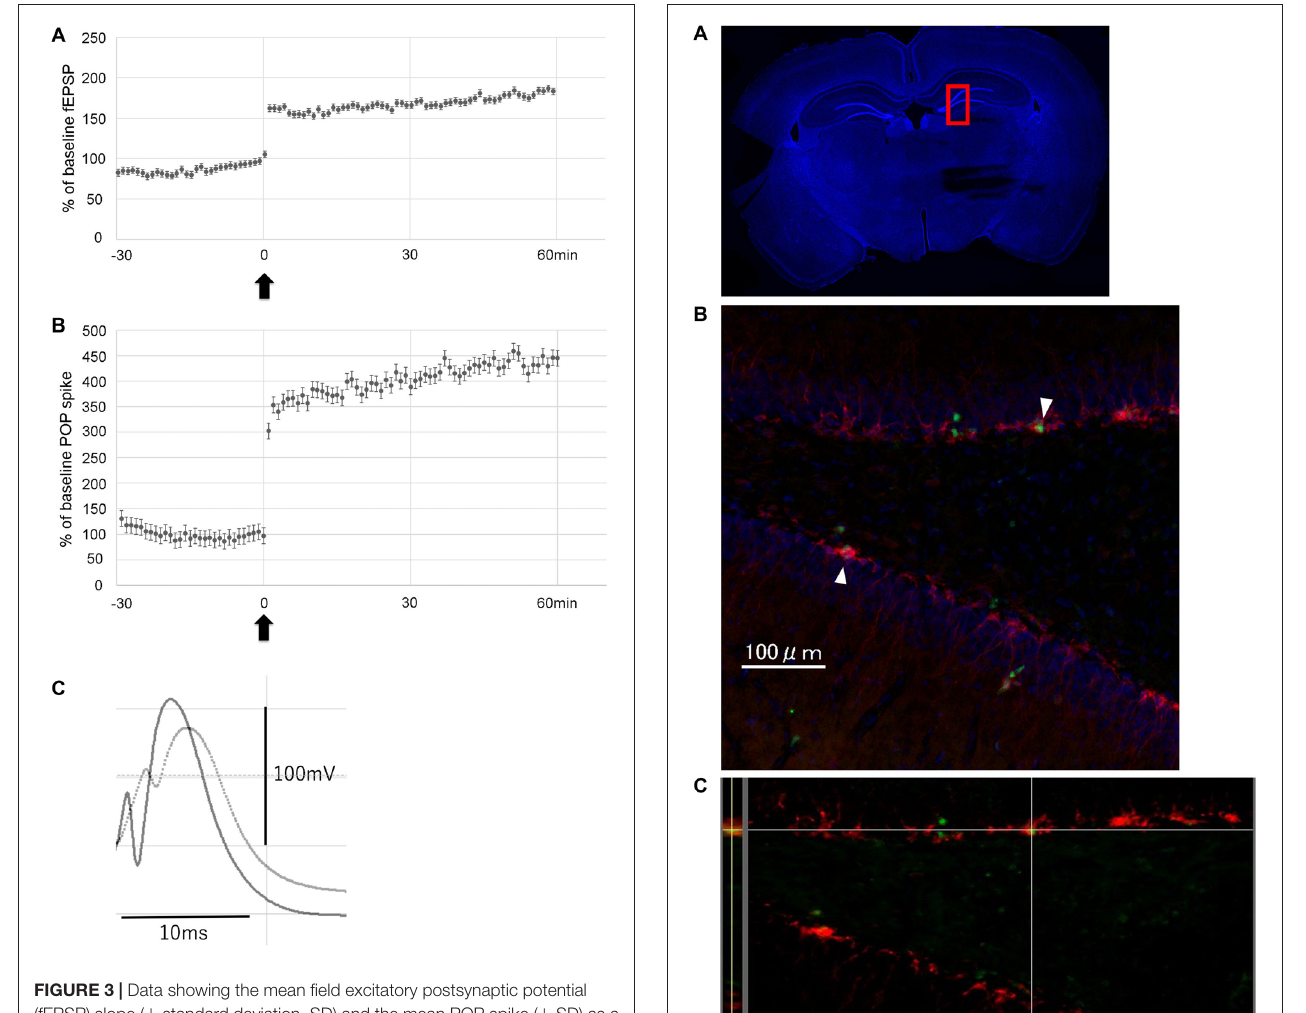
respectively). In the stimulated hippocampi, the number of